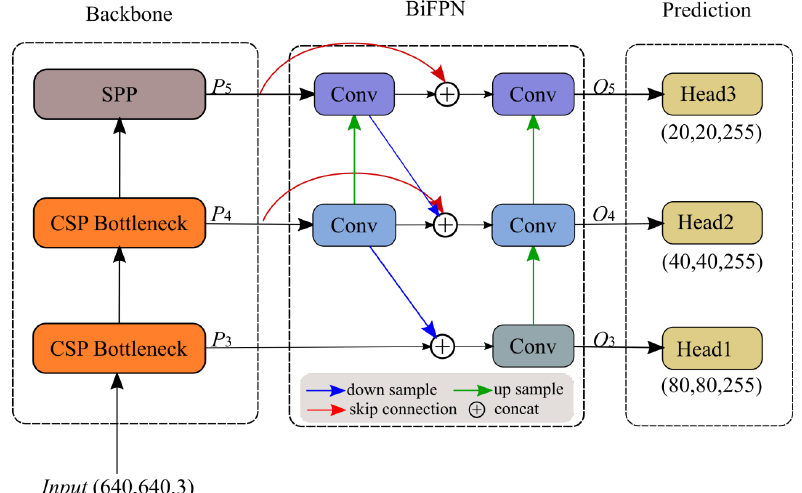
Figure 6. Scheme diagram of the proposed model.